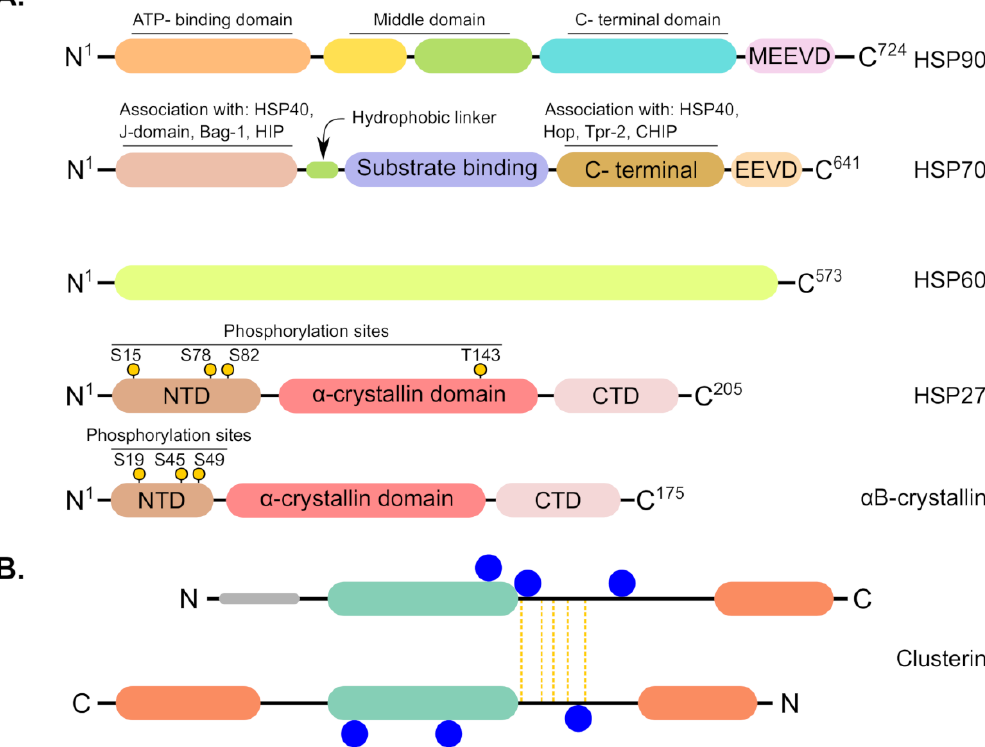
Figure 4. Schematic representation showing structural features of common chaperones involved in ovarian cancer. ( A ) From top to bottom; HSP90, HSP70 and HSP60 are ATP-dependent chaperones that harbor ATP binding sites within their structures whereas sHSPs such as HSP27 and αB-crystallin do not possess ATP binding sites. All HSPs have N-terminal and C-terminal domains (NTD and CTD) besides middle domain. sHSPs contain phosphorylation sites at specific serine (S) or threonine (T) residues, depicted as black sticks with yellow circles at their ends, and they are characterized by conserved α-crystallin domain that is flanked by variable N- and C-terminal ends. ( B ) The main structural topology of clusterin (CLU). Synthesis of CLU includes removal of the short 22-residue signal peptide (grey) as it enters to the ER lumen. Subsequent posttranslational proteolysis occurs in the Golgi where the protein is cleaved into α-(upper) and β-(lower) chains. The α- and β-chains are covalently connected by five disulfide bridges extending from ‘core region’ of both chains (yellow vertical lines). In addition, the α-chain is predicted to contain one amphipathic α-helix while the β-chain contains two α-helices. Moreover, both chains have a coiled coil structure (light green) and the mature protein is known to have six N-linked glycosylation sites (blue circles).